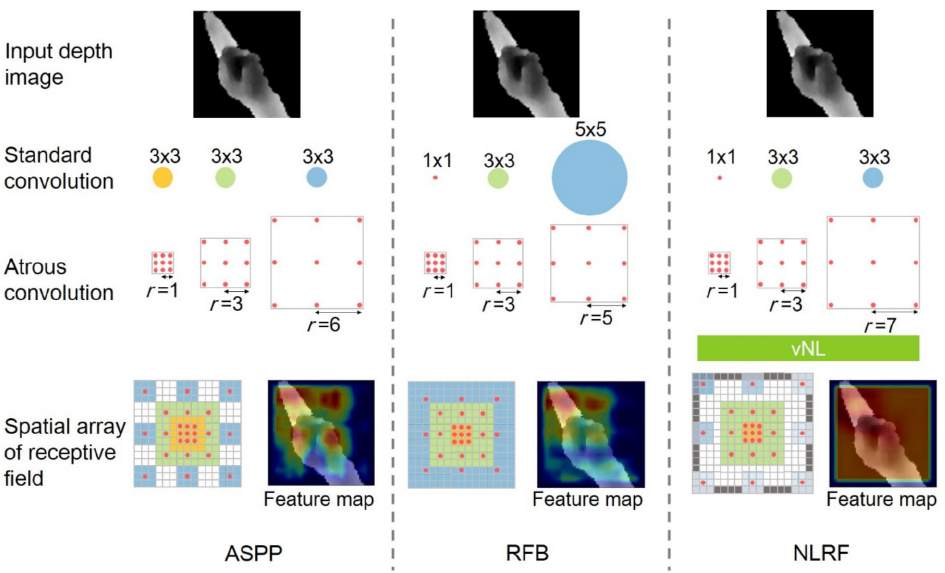
Figure 4. We adjusted the RF sizes in the original ASPP and RFB for a fair comparison. The feature maps are derived from the output of ASPP, RFB, and NLRF. The dark outer region of the feature map of the NLRF is zero-padded to fit the RF of atrous convolution with rate r = 7. vNL: variant of non-local block; r : atrous sampling